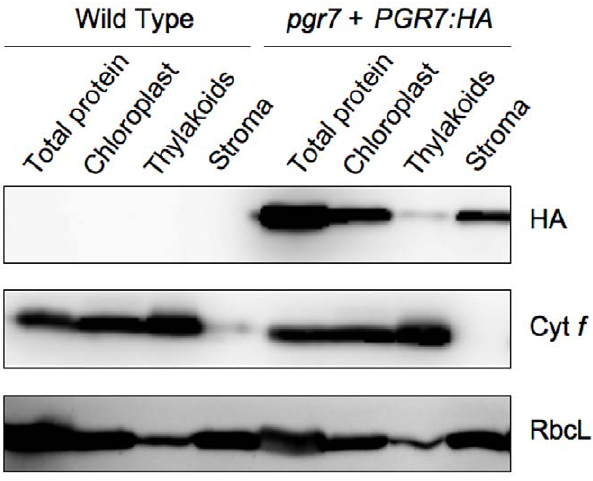
Figure 8. Chloroplast localization of an HA-tagged PGR7 protein. Immunoblot analysis of the HA epitope, cytochrome f (Cyt f ), and RbcL was performed with proteins solubilized from leaves, chloroplasts, thylakoids, and stroma of the wild type and the pgr7 mutant complemented with a PGR7:HA construct.